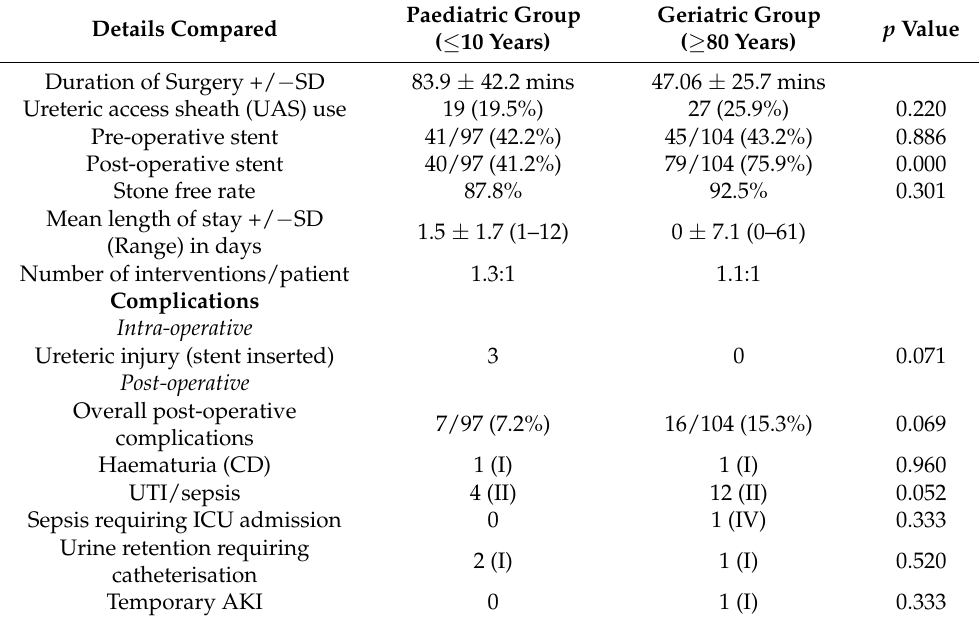
Table 2. Intra-operative and post-operative outcomes of FURSL for both groups (CD—Clavien–Dindo classification of post-operative complications, UTI—urinary tract infection, ICU—intensive care unit, and AKI—acute kidney